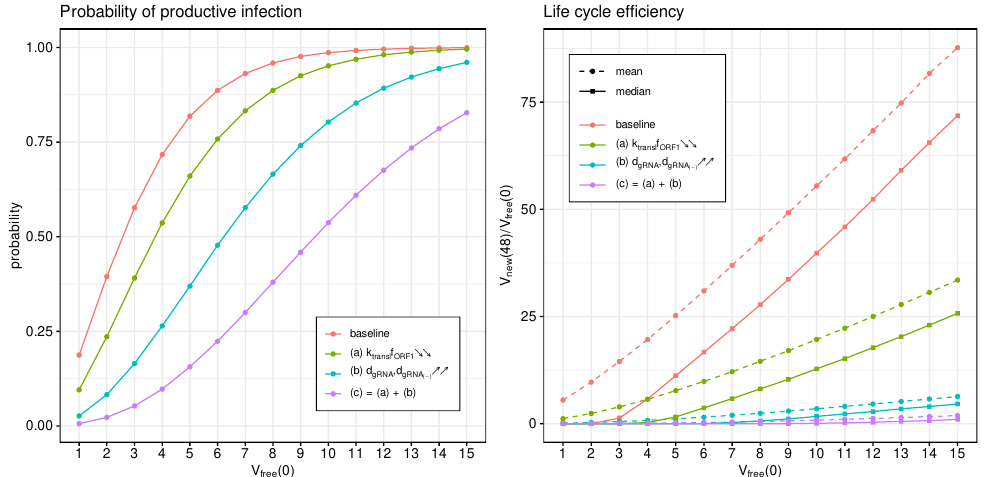
Figure 9. Type I IFN-mediated effects on the probability of non-degenerate infection ( left ) and the efficient reproduction number for MOI ranging from 1 to 15 ( right ). The ascending/descending arrows in the legend show the four-fold increase/decrease in the indicated